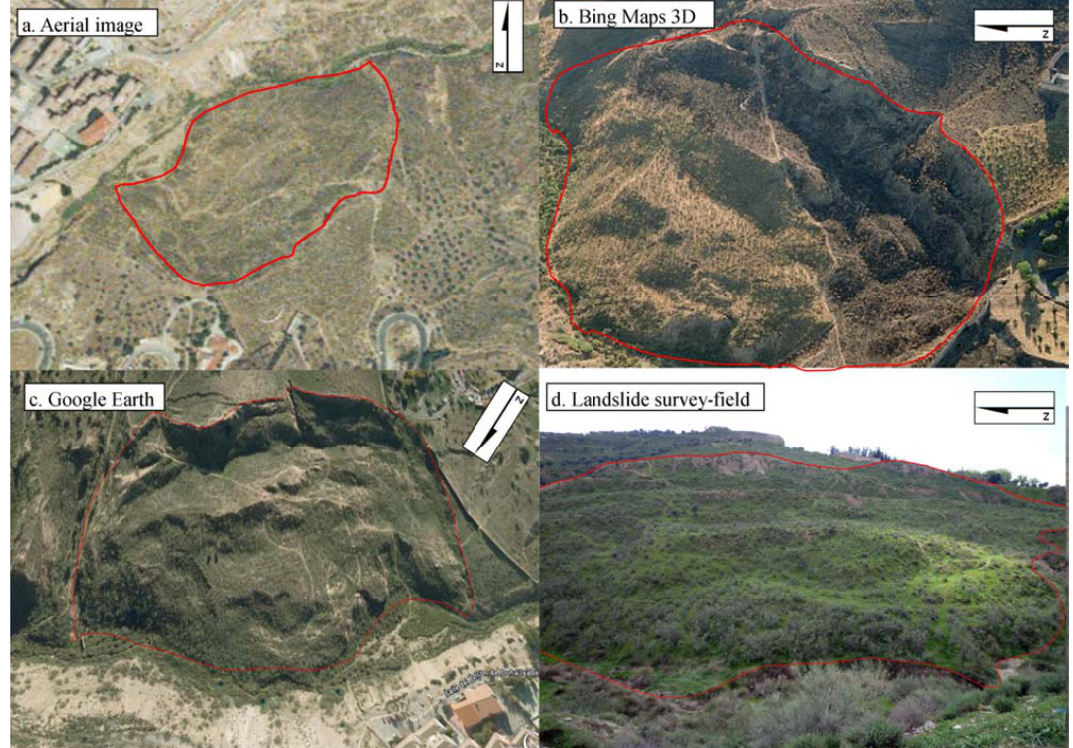
Fig. 4. Beiro translational slide view by different Fig. 4 – Bei iro translation nal slide view by different teechniques.